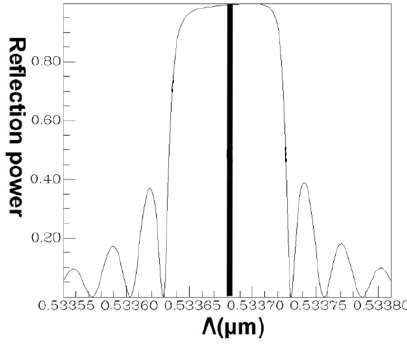
Figure 12. Plot between the FBG period and the reflection power for the total counterpropagating HE (core mode) with Λ = 0.5336803 μm. 11